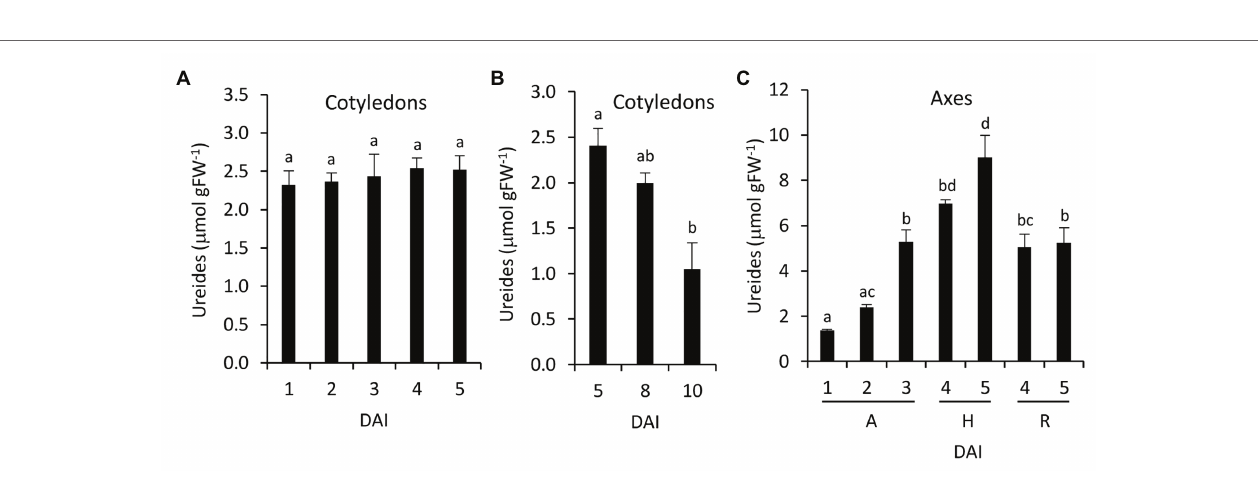
FIGURE 5 | Nucleic acid degradation during germinative and early postgerminative development in common bean. ssDNA activity was determined in cotyledons (A,B) , and embryonic axes (C) . Values are mean ± SE of at least three biological replicates, with two technical replicates for experiment. Different letters indicate significant differences among the developmental stages as analyzed by ANOVA followed by Tukey’s post hoc analysis ( p ≤ 0.05). DAI, days after the start of the imbibition; A, embryonic axes; H, hypocotyls; and R, radicles.